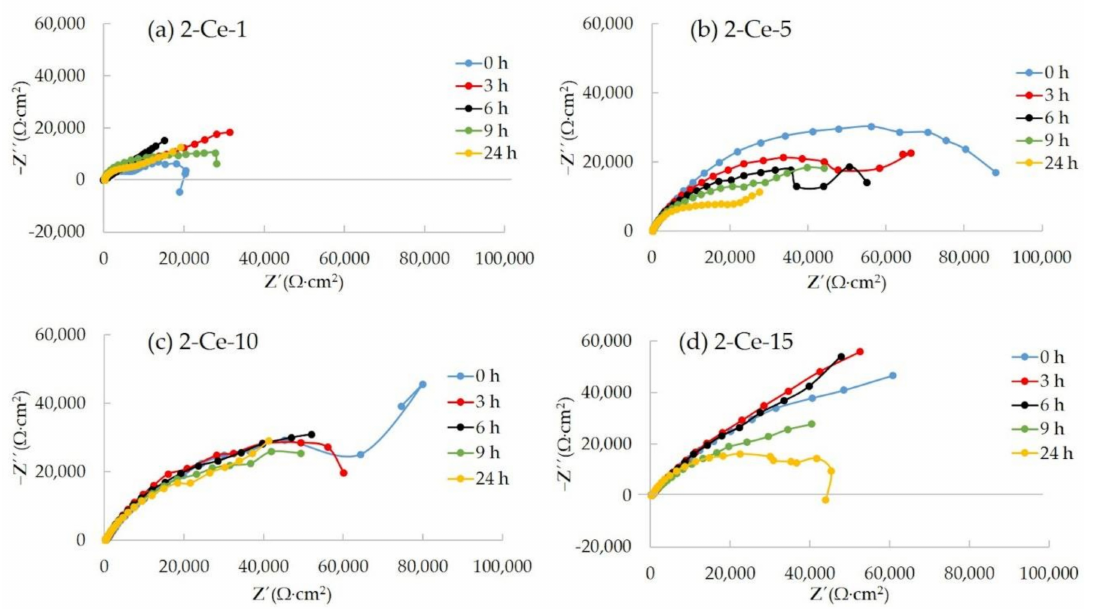
Figure 6. Nyquist diagrams during the immersion test in 0.5% NaCl of 2024 samples: ( a ) 2-Ce-1, ( b ) 2-Ce-5, ( c ) 2-Ce-10, and ( d ) 2-Ce-15.